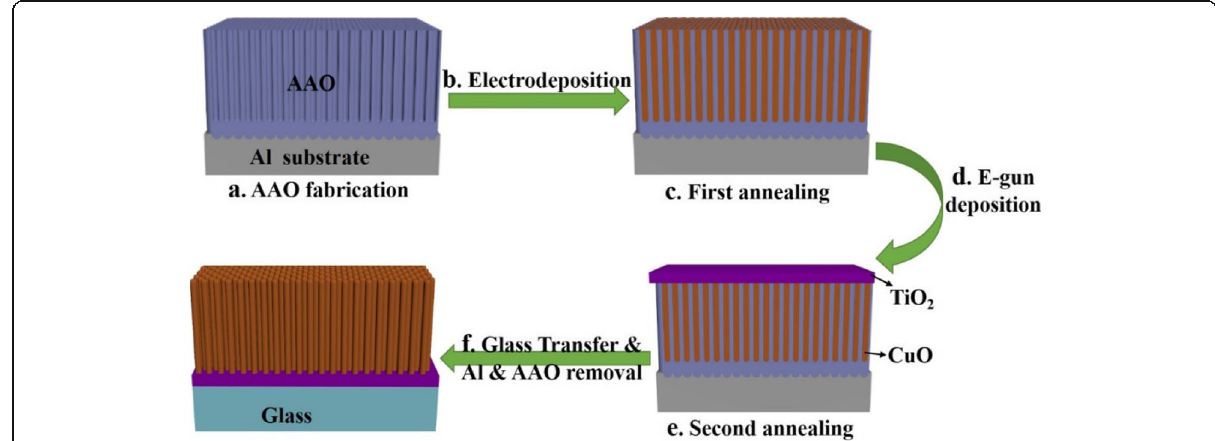
Fig. 1 Schematic of the process flow for fabrication of CuO/TiO 2 hybrid nanorod (NR)